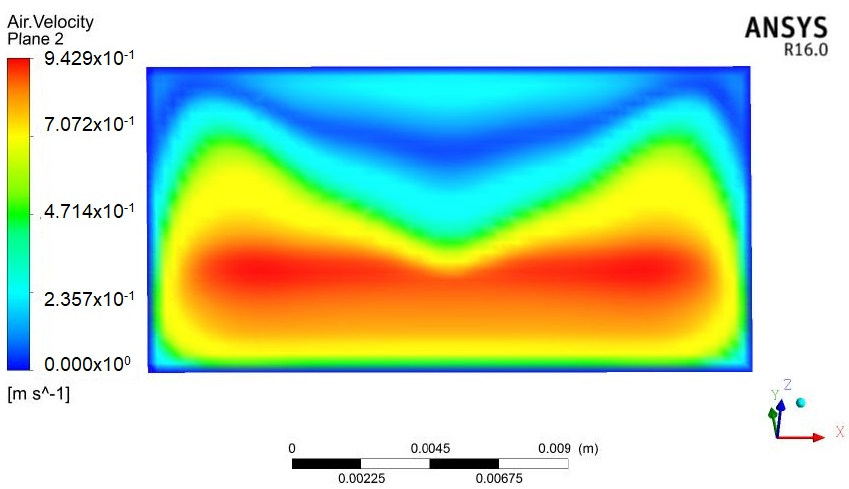
Figure 3. Air velocity at plane 2.